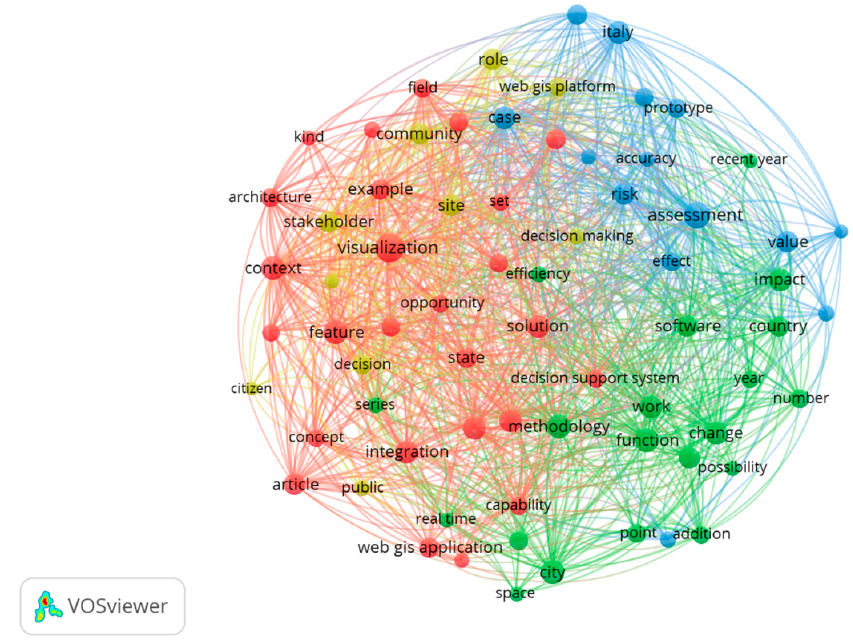
Figure 6. Term co-occurrence network map based on the text data obtained from WoS.